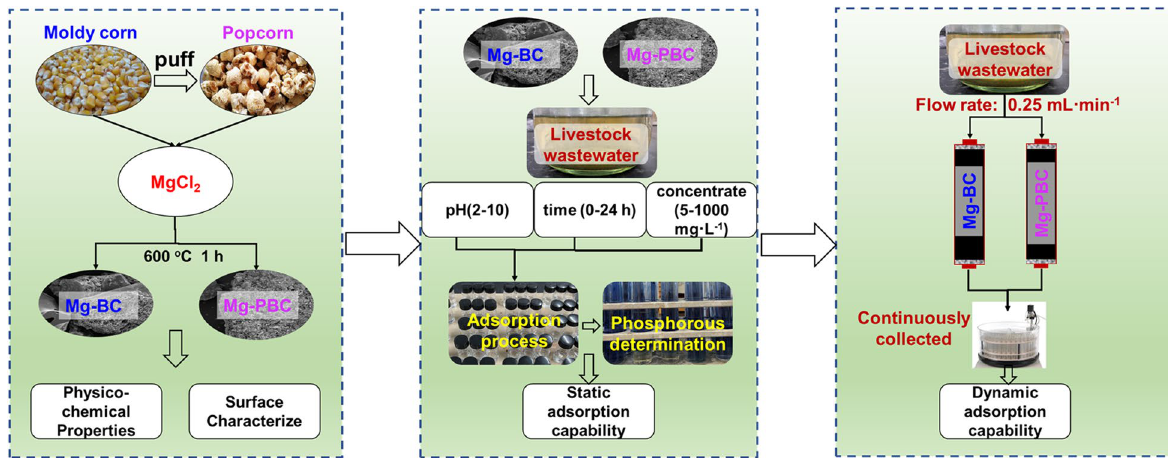
Fig. 1 Schematic diagram of material preparation, static and dynamic adsorption